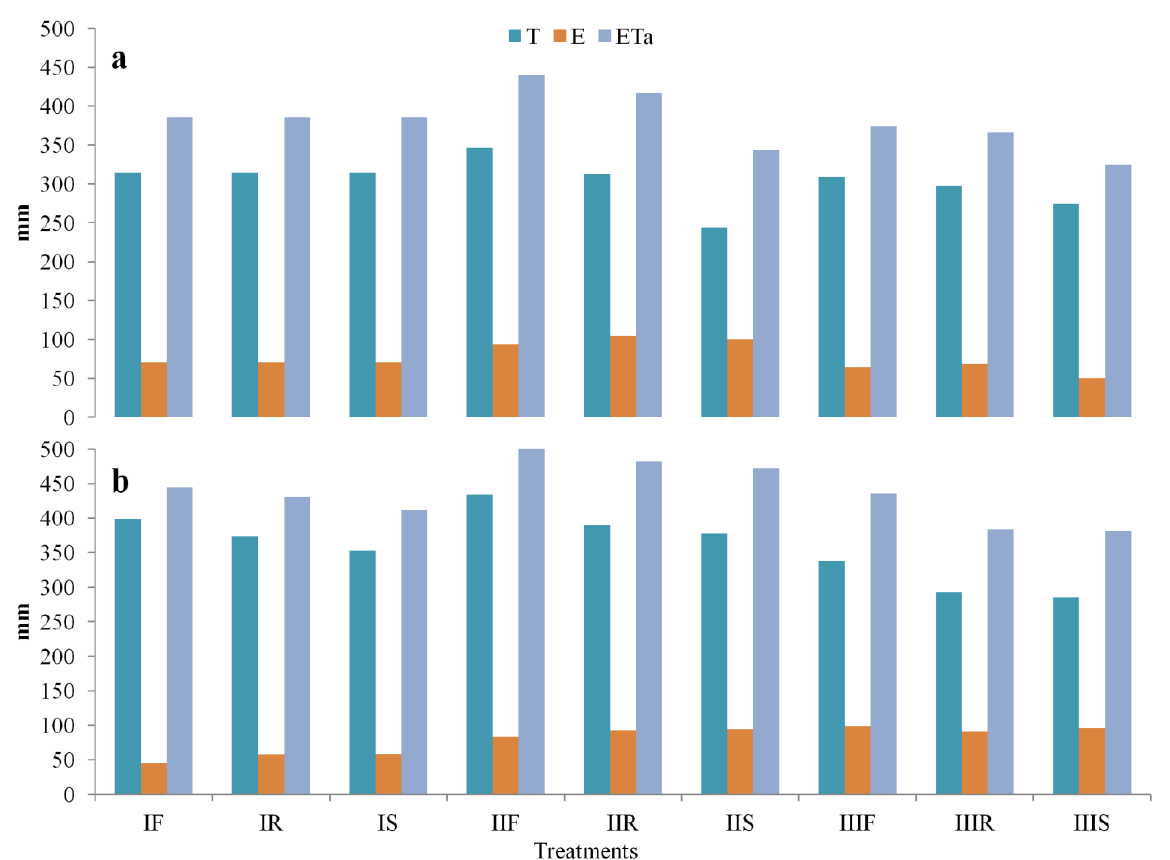
Figure 6. Evapotranspiration by irrigation treatment and sowing periods, calculated via the dual coefficient (IF, IR, IS, IIF, IIR, IIS, IIIF, IIIR, and IIIS): Three sowing periods (I, II and III), Actual evapotranspiration ( ETa ), evaporation (E), transpiration (T), full irrigation (F), deficit irrigation R, and deficit irrigation S in 2019 ( a ) and 2020 ( b ).